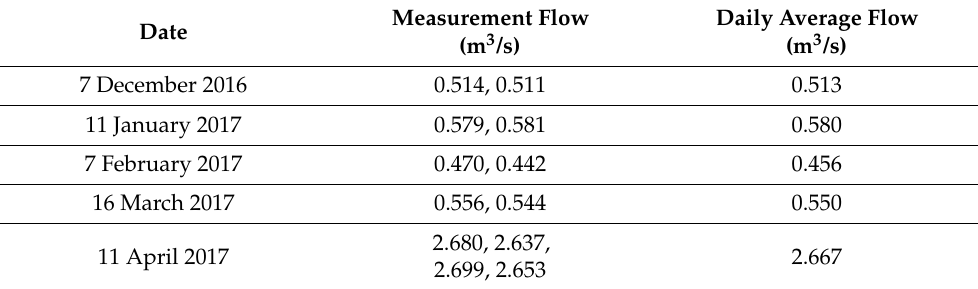
Table 2. Results of the on-site flow